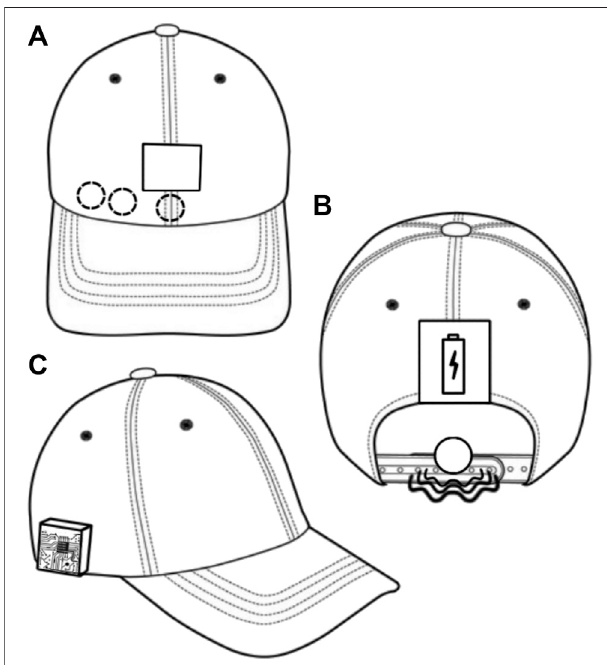
FIGURE 3 | The e-Cap. (A) Front view (electrode positions indicated by dashed circles, touch interface by solid rectangle). (B) Rear view (Vibromotor indicated by solid circle and waves, battery by solid rectangle). (C) Side view (showing the electronics box).